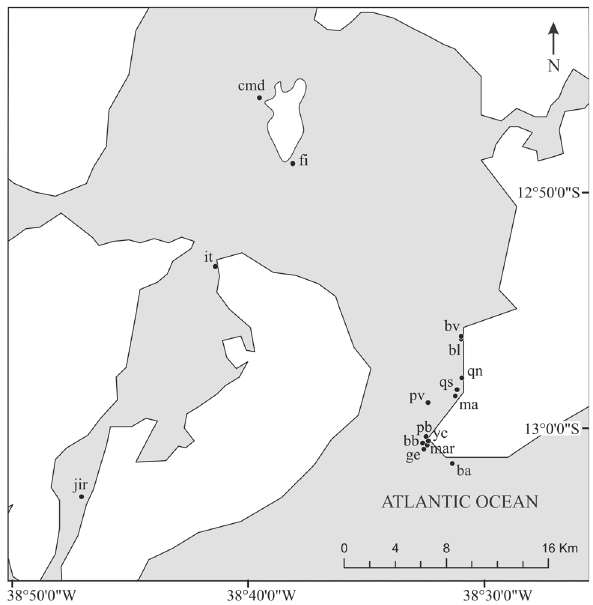
Figure 1. Collecting sites in Todos os Santos Bay, Bahia, Brazil. (cmd) Canal Madre Deus, (fi) Frades Island, (it) Itaparica pier, (bv) Boa Viagem beach, (bl) shipwreck Blackadder, (qn) Quebramar Norte, (qs) Quebramar Sul, (ma) Bahia Marina, (yc) Yacht club, (pv) Pedra Verde, (mar) shipwreck Maraldi, (bb) Barra bouy, (ge) shipwreck Germania, (pb) Porto da Barra, (ba) Barra, (jir) Jiribatuba.